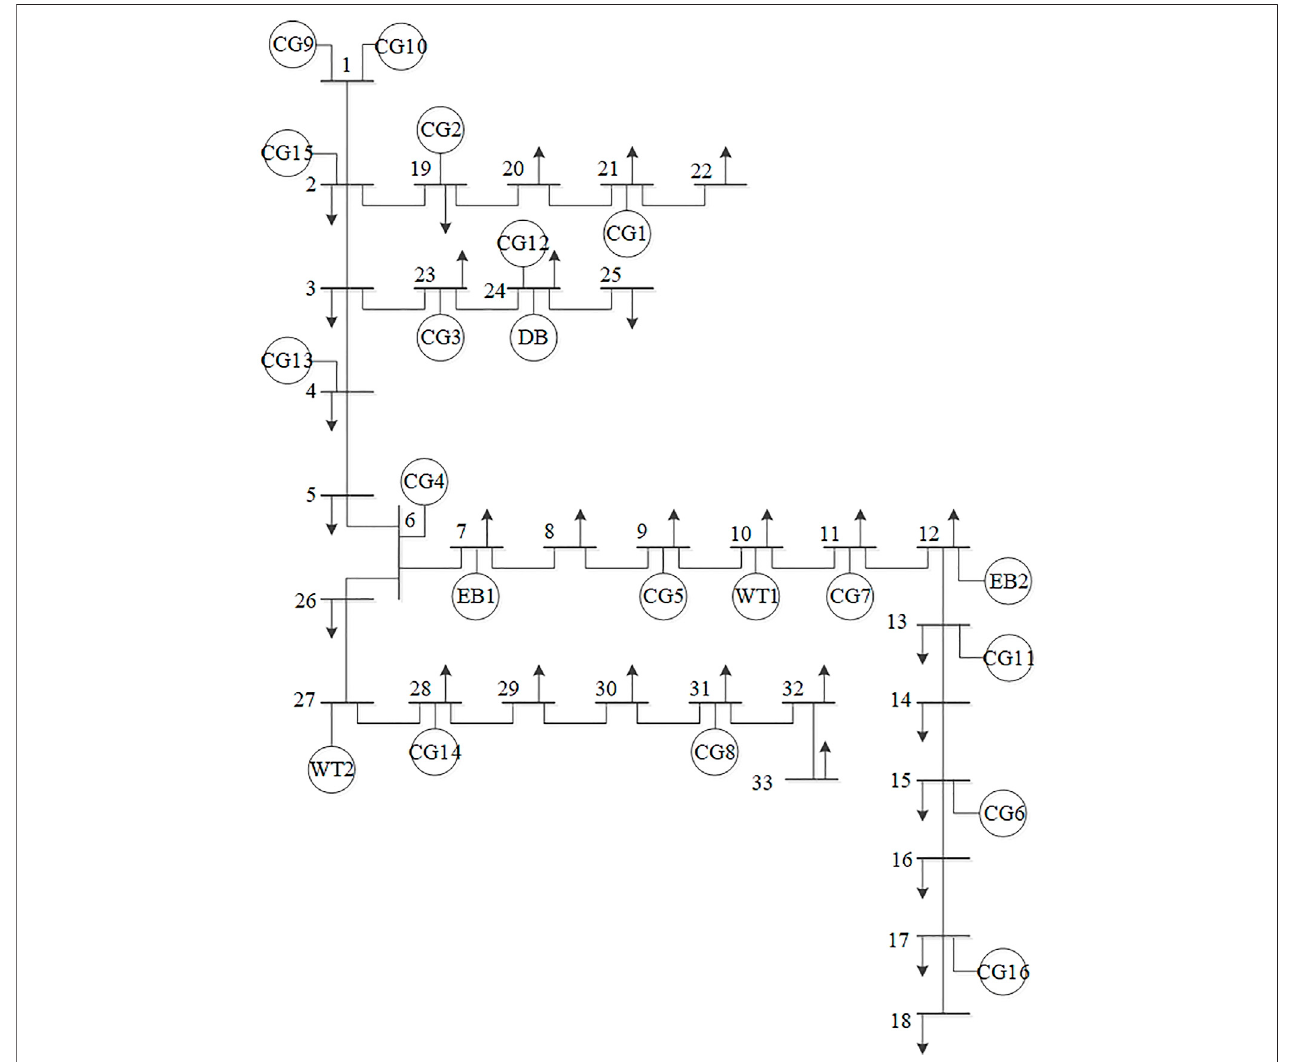
FIGURE 2 | Diagram of network of the isolated